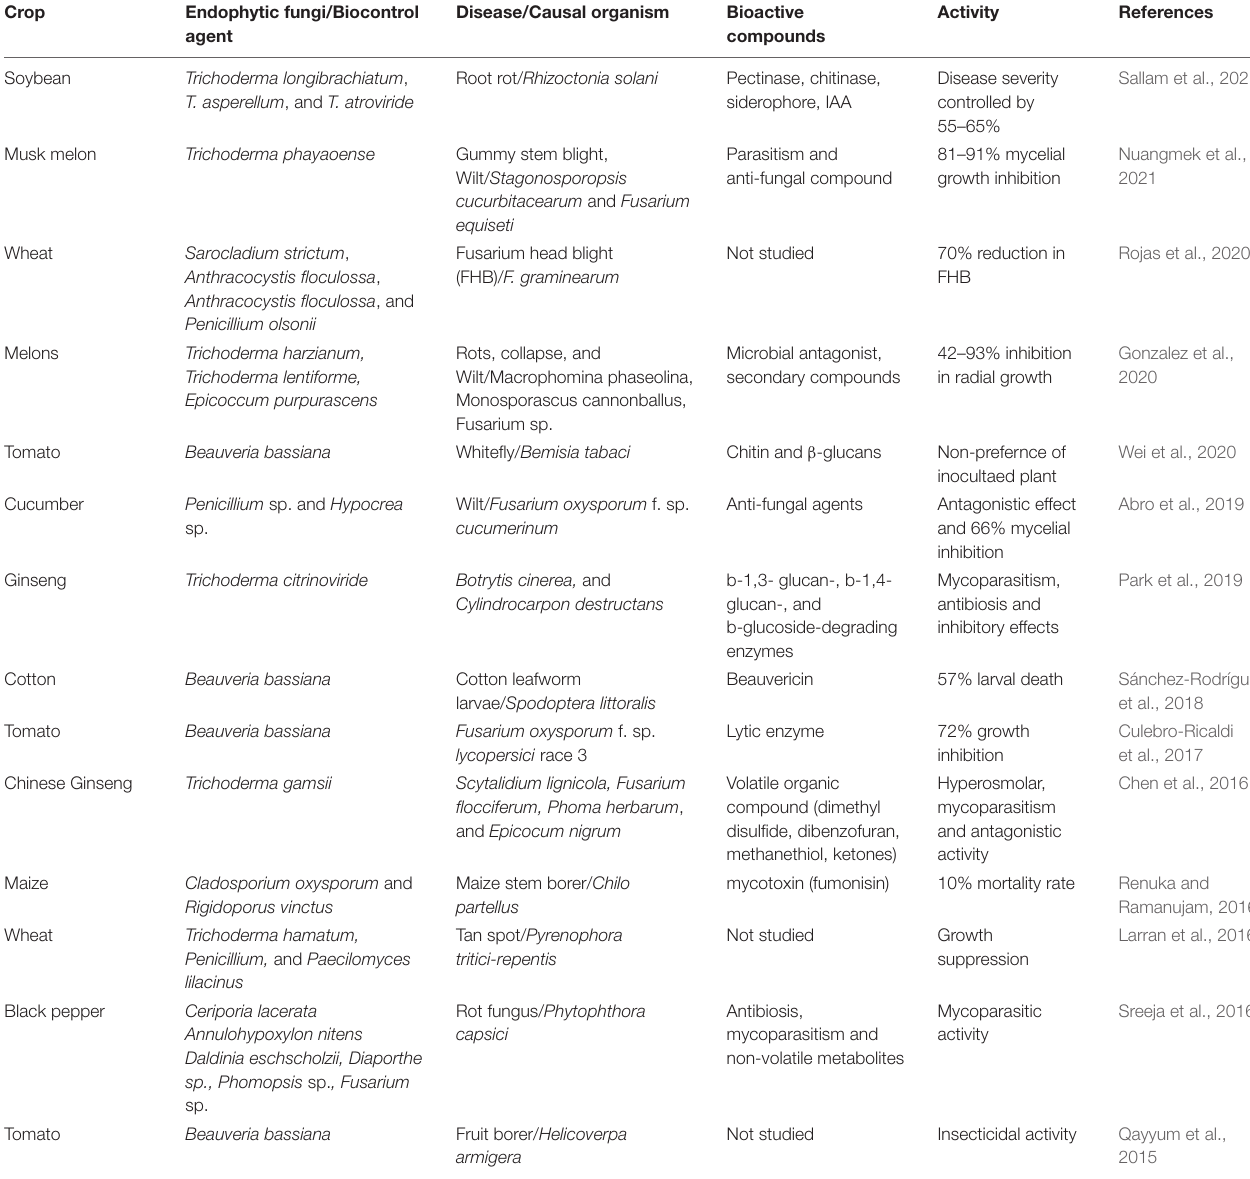
TABLE 3 | Recently reported fungal endophytes mediated biotic stress management in agricultural crops